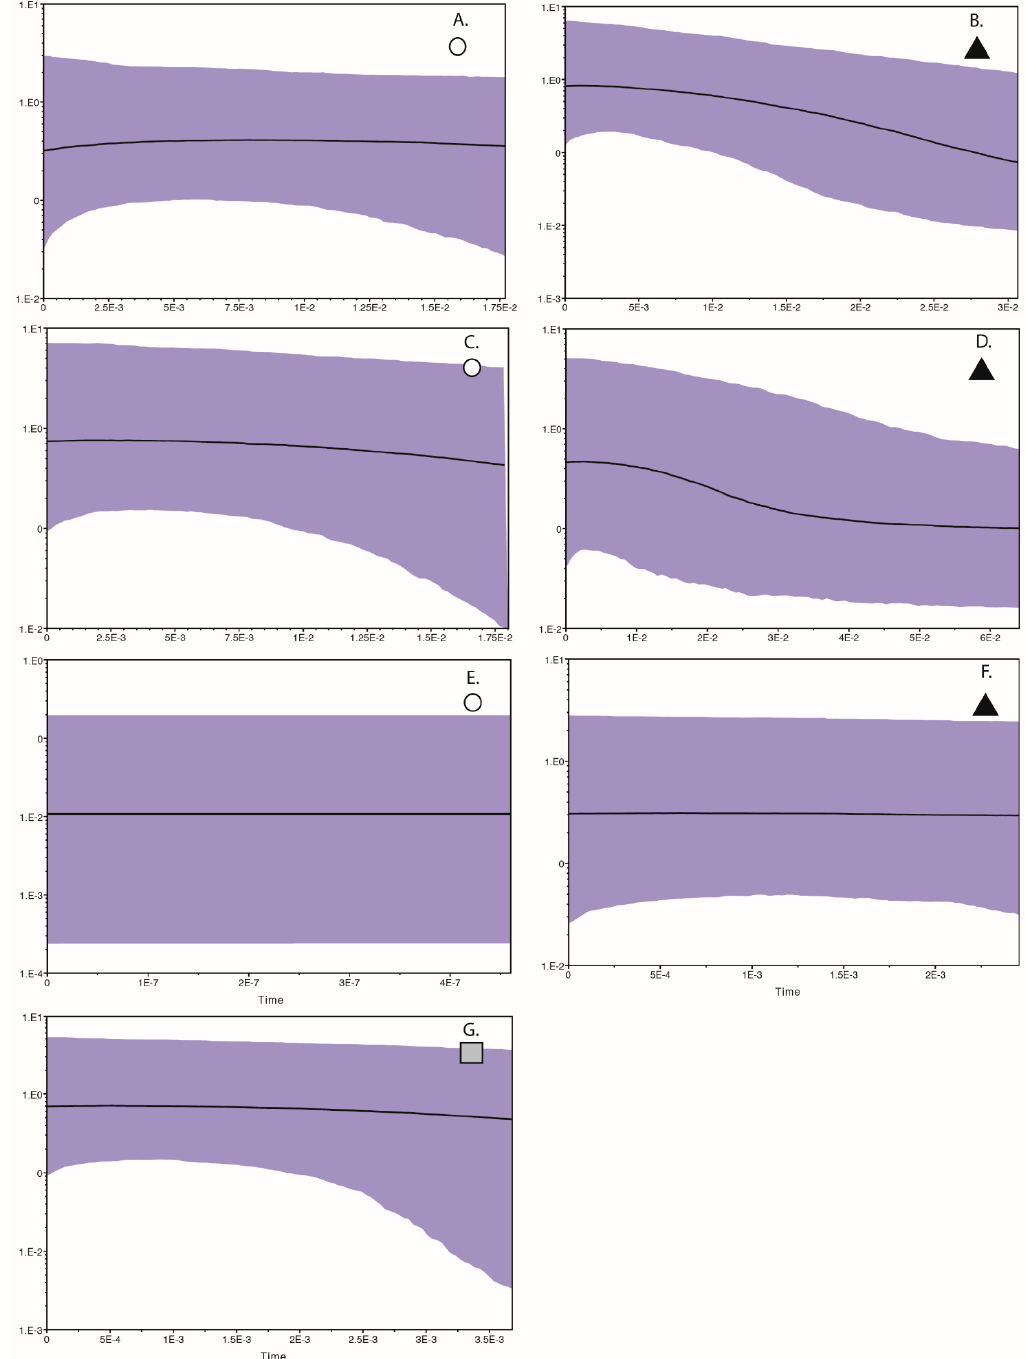
Figure 4. Bayesian Skyline Plots for each population recovered in the haplotype analyses presented in Figures 1–3, where the x axis is time in thousands of years (before present, thus a negative value relative to time 0 which equals present), and the y axis is the estimate of population size (positive or negative, relative to 0 population change). Panel ( A , B ) are for the two Curruca subcoerulea populations; panels ( C , D ) are for the two Laniarius atrococcineus populations; panels ( E – G ) are for the three Trichomaela leucomelas